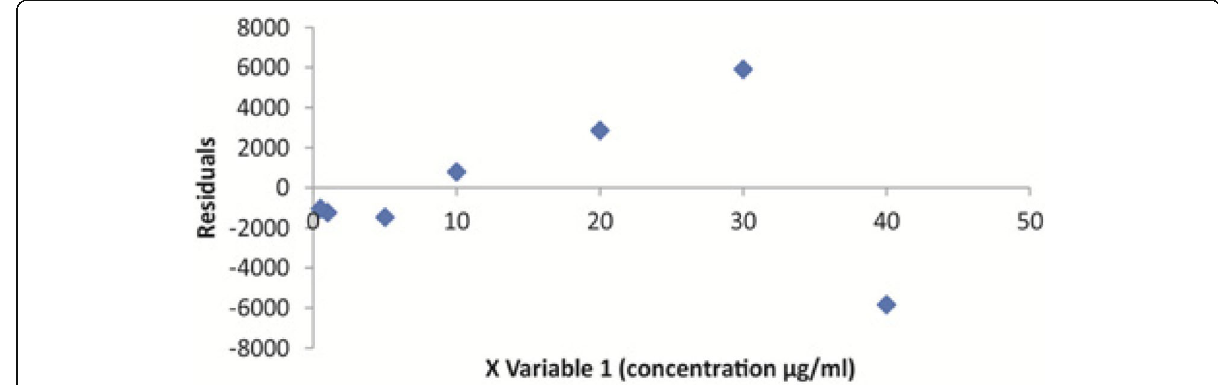
Fig. 6 Residual plot indicating appropriateness of the linear regression